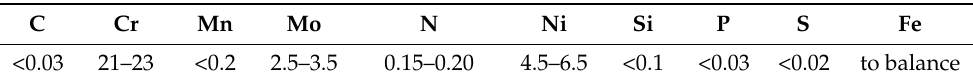
Table 5. Nominal chemical composition of the 2205 steel